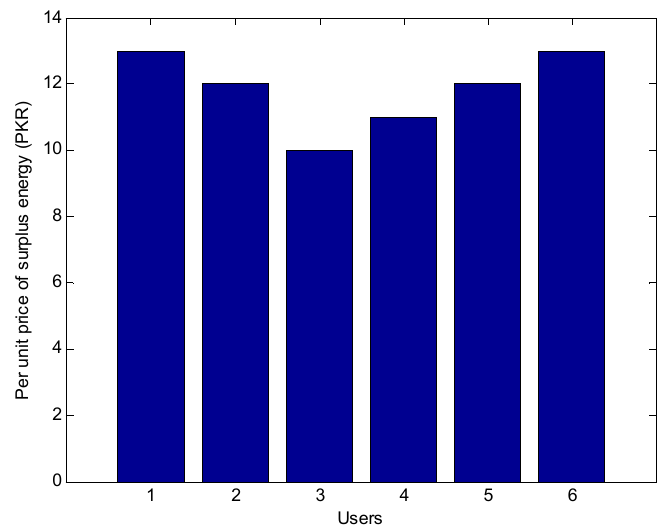
Figure 3. Shortage/surplus energy before optimization.